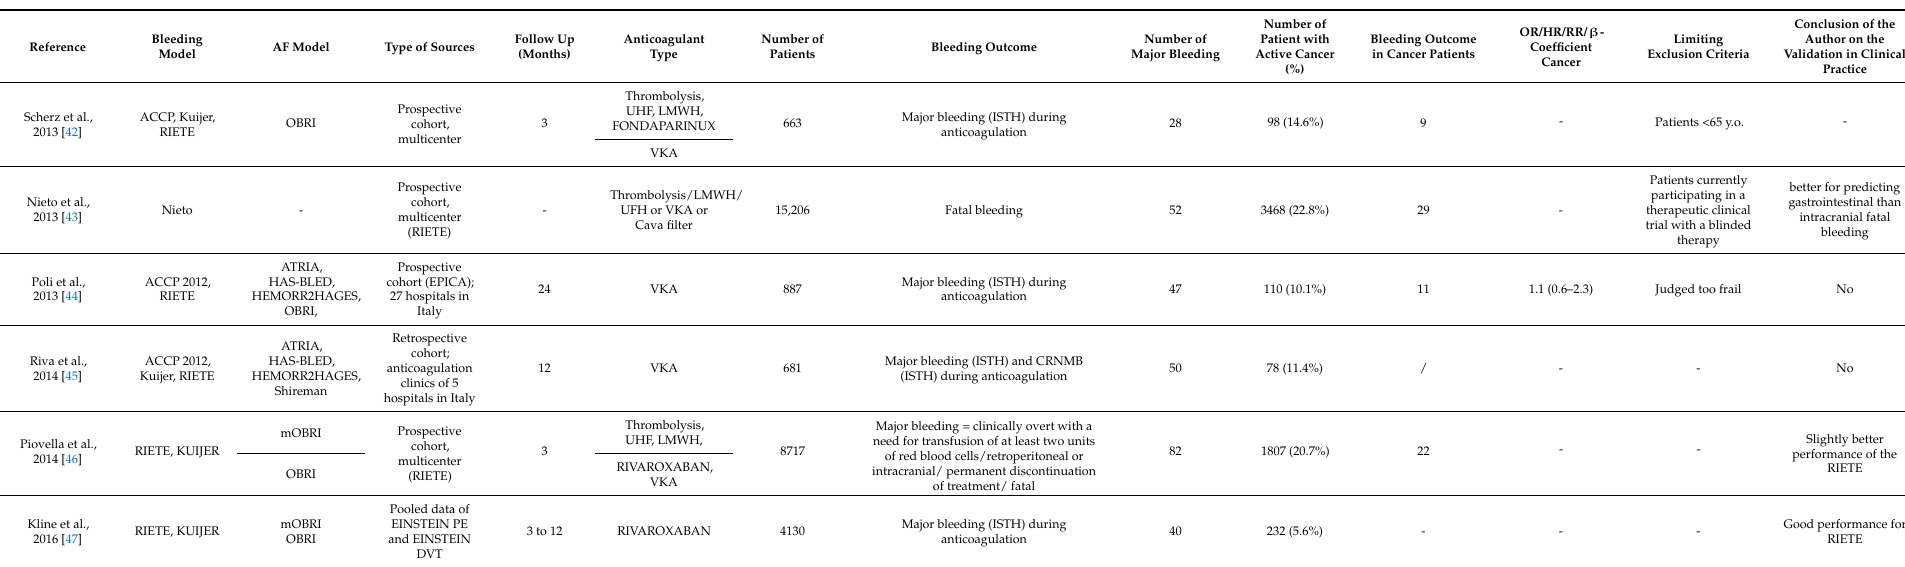
Table 5. Validation studies for risk assessment